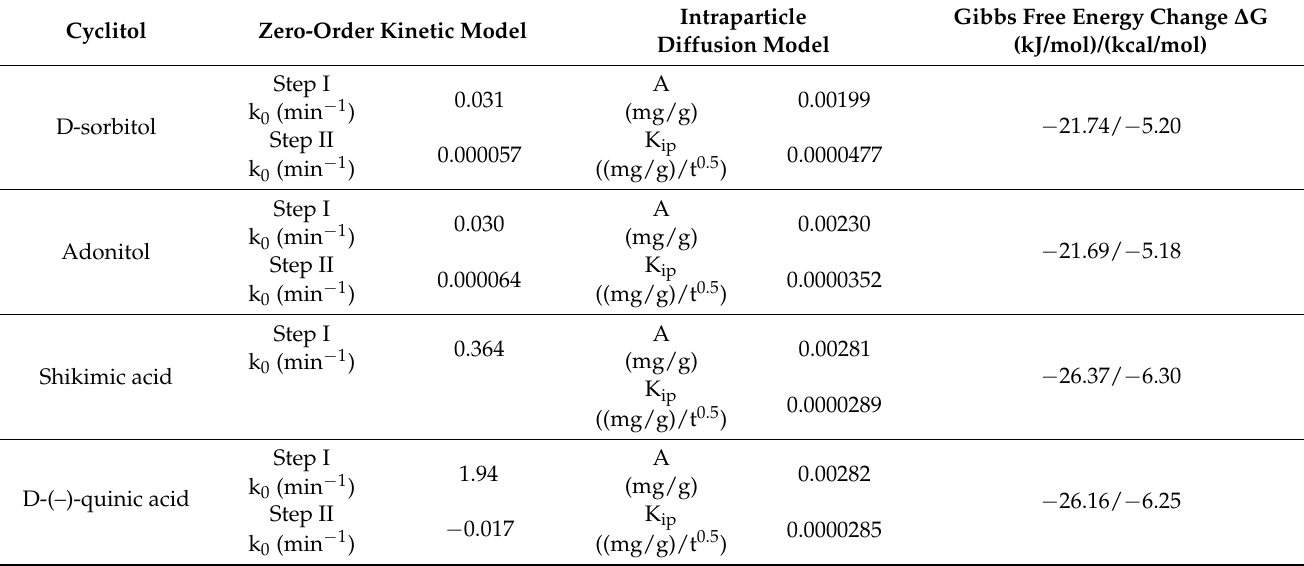
Table 1. Parameters of kinetic models and Gibbs free energy change values of BSA–cyclitol interactions.